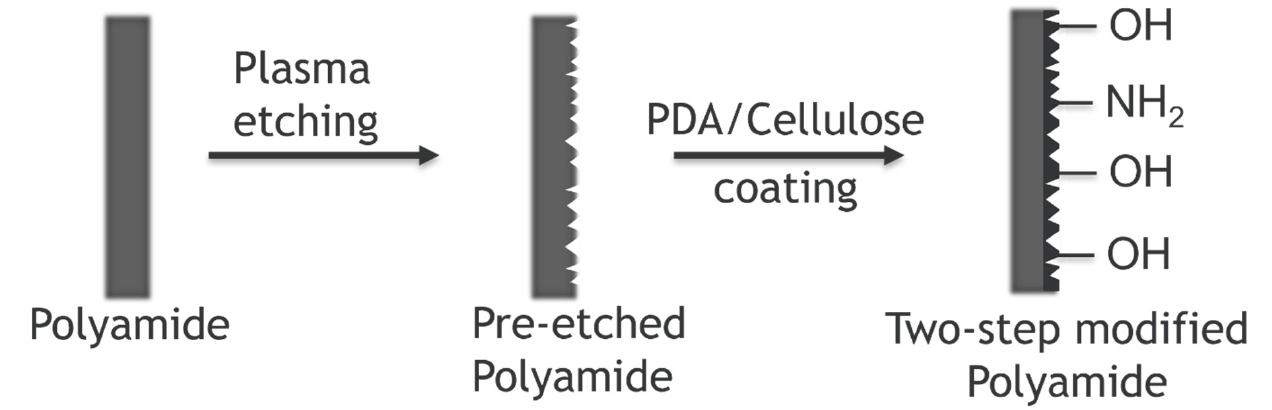
Figure 5. A fabrication of hydrophilic polyamide fabrics for produced water treatment.